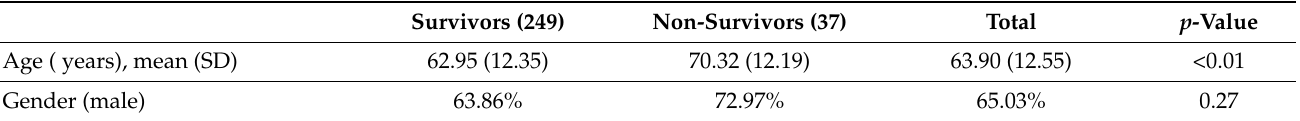
Table 1. Description of the COVID-19 patients included in the study. Demographic and clinical characteristics (means and standard deviations) of the patients who survived versus those who did